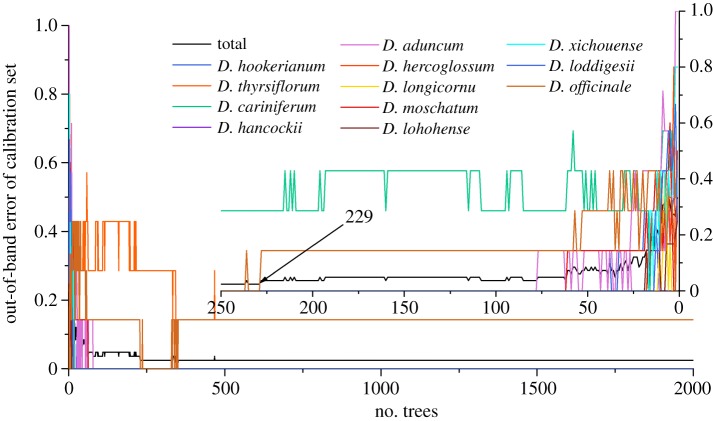
The selection results of ntree using the mid-level fusion strategy.